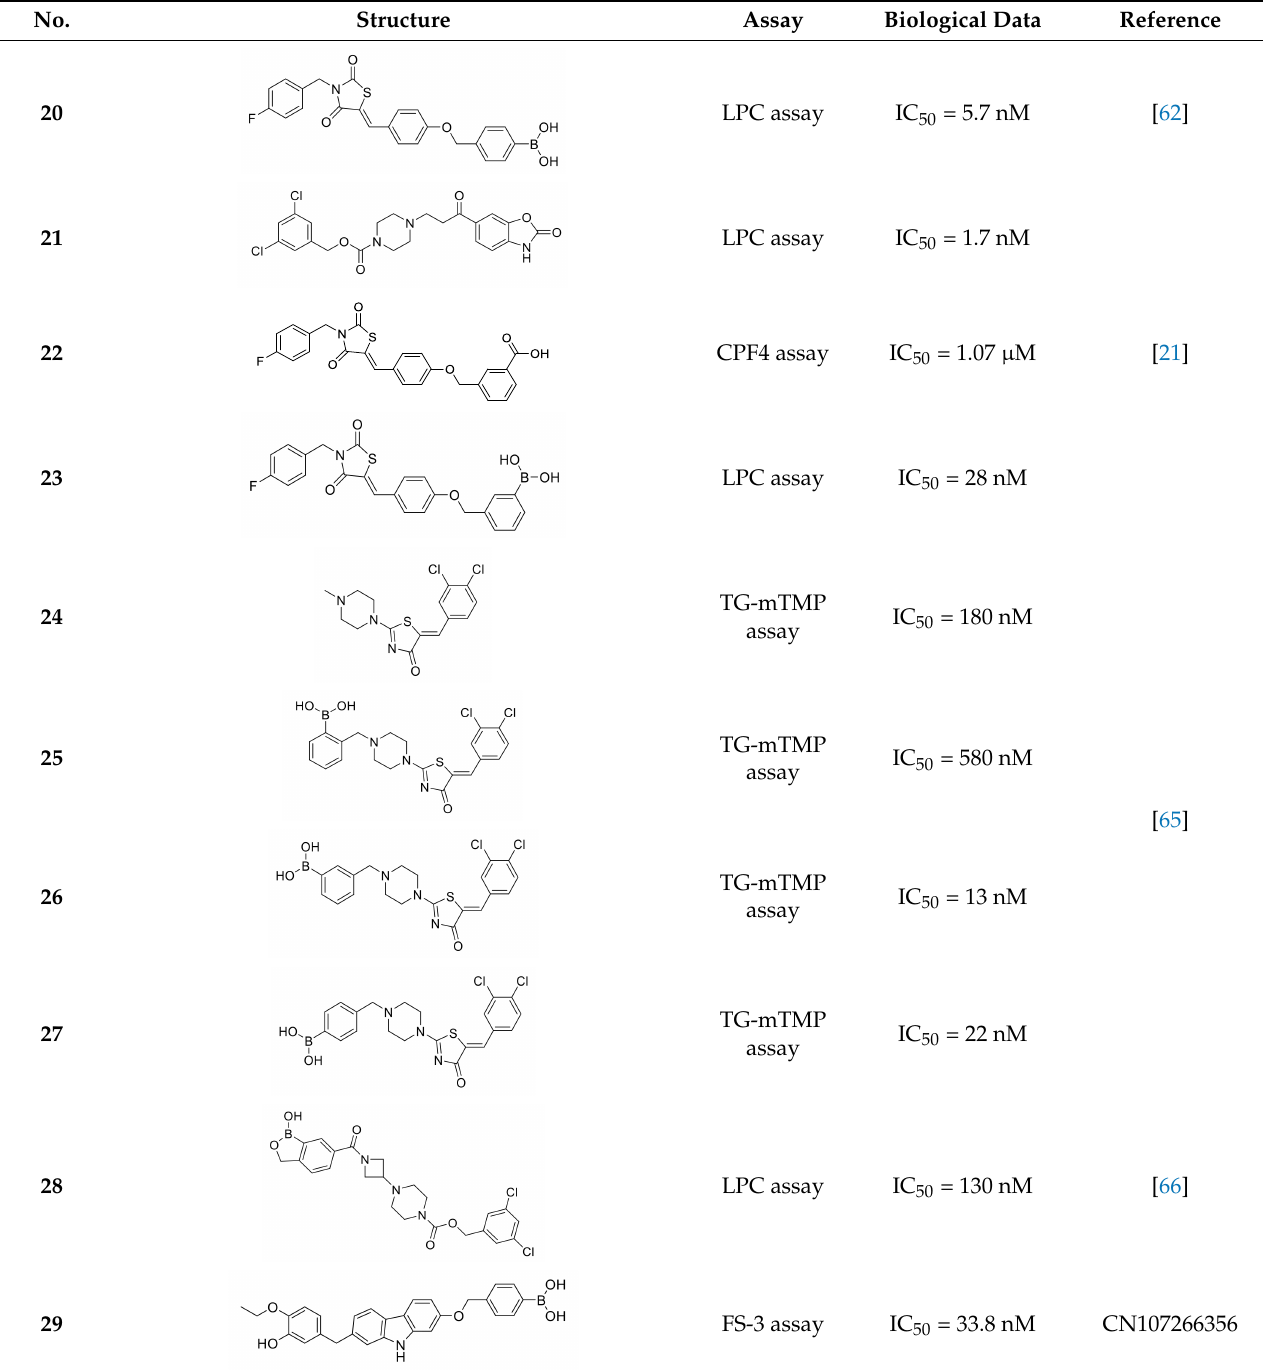
Table 3. Compound 20 – 42 .